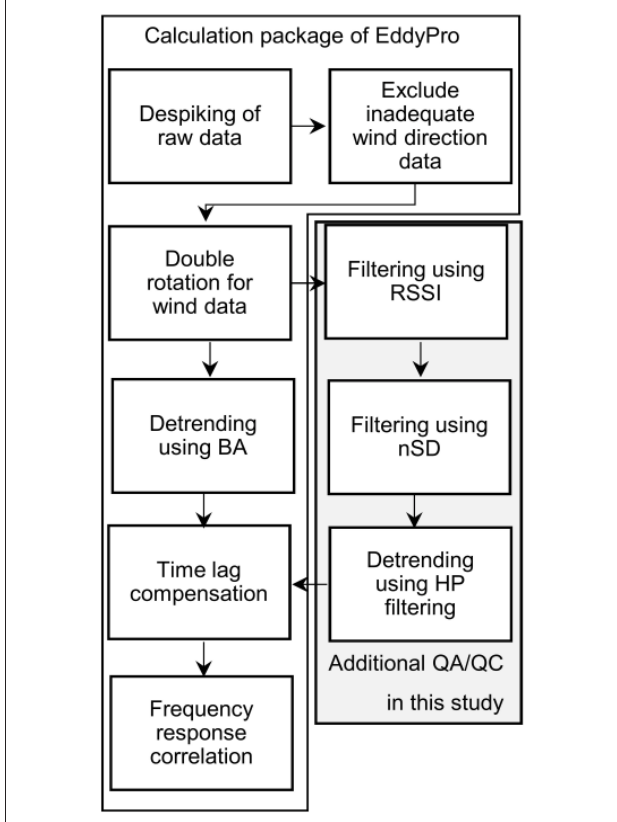
FIGURE 2 | Post-processing methods for EC flux calculations. The EC CO 2 flux was calculated by using conventional post-processing (PP1) in EddyPro. The corrections involved in PP1 have been described in previous publications (e.g., Lee et al., 2004). Detrending was performed by using block averaging (BA). Our new post-processing method (PP2) included two data-filtering steps based on the received signal strength indication of the CO 2 sensor and the standard deviation of the CO 2 and water vapor concentrations divided by the corresponding average standard deviation during the measurement period (nSD). Detrending in PP2 was performed by using high-pass filtering (Massman,